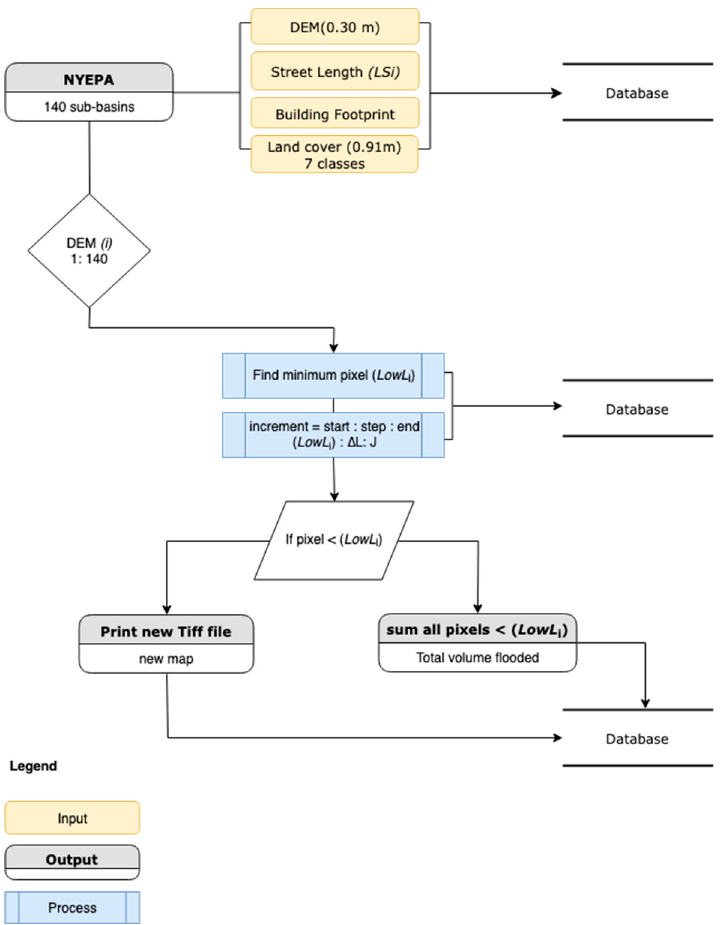
Figure 3. Flow chart describing the process of building the map flood database.